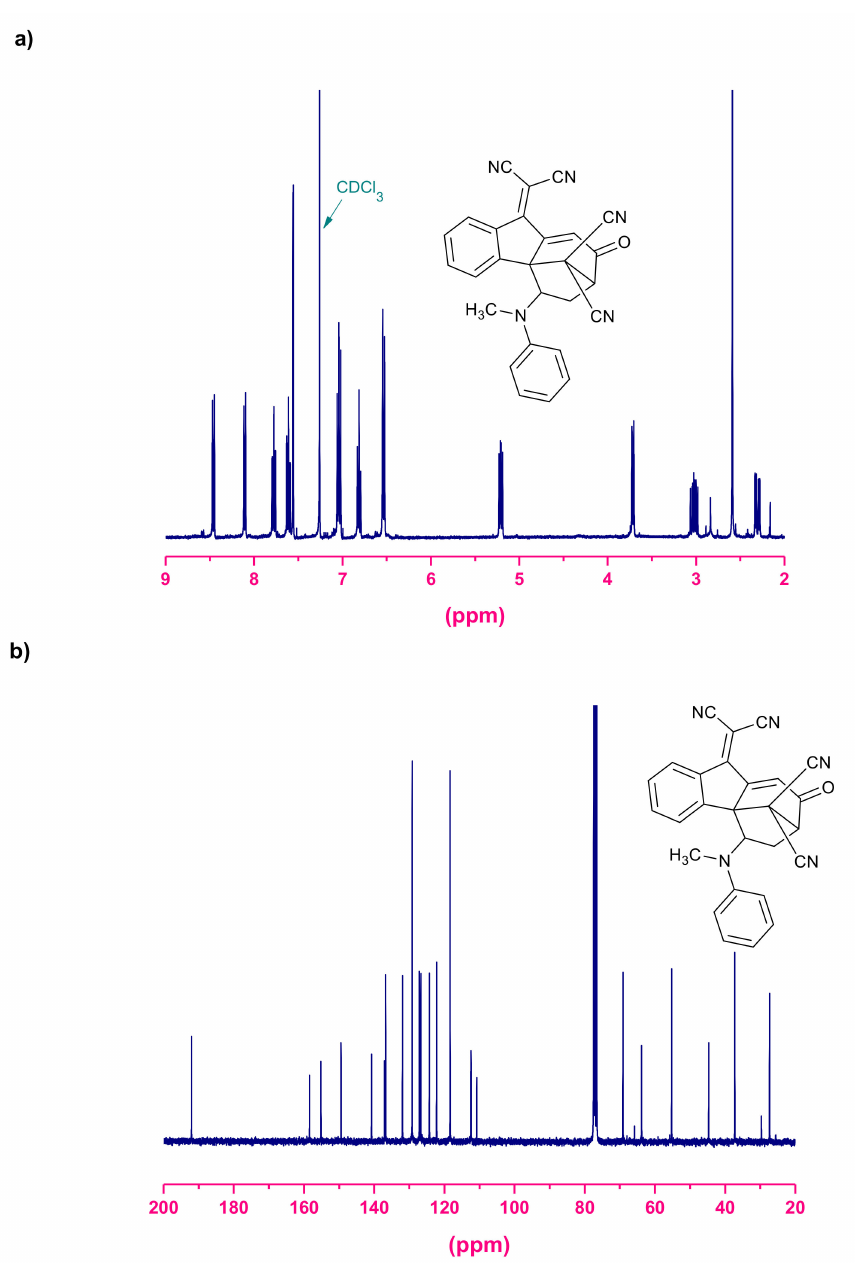
Figure 3. Proton nuclear magnetic resonance ( 1 H-NMR) spectrum ( a ) and carbon-13 nuclear magnetic resonance ( 13 C NMR) spectrum ( b ) of cyclized compound PP26